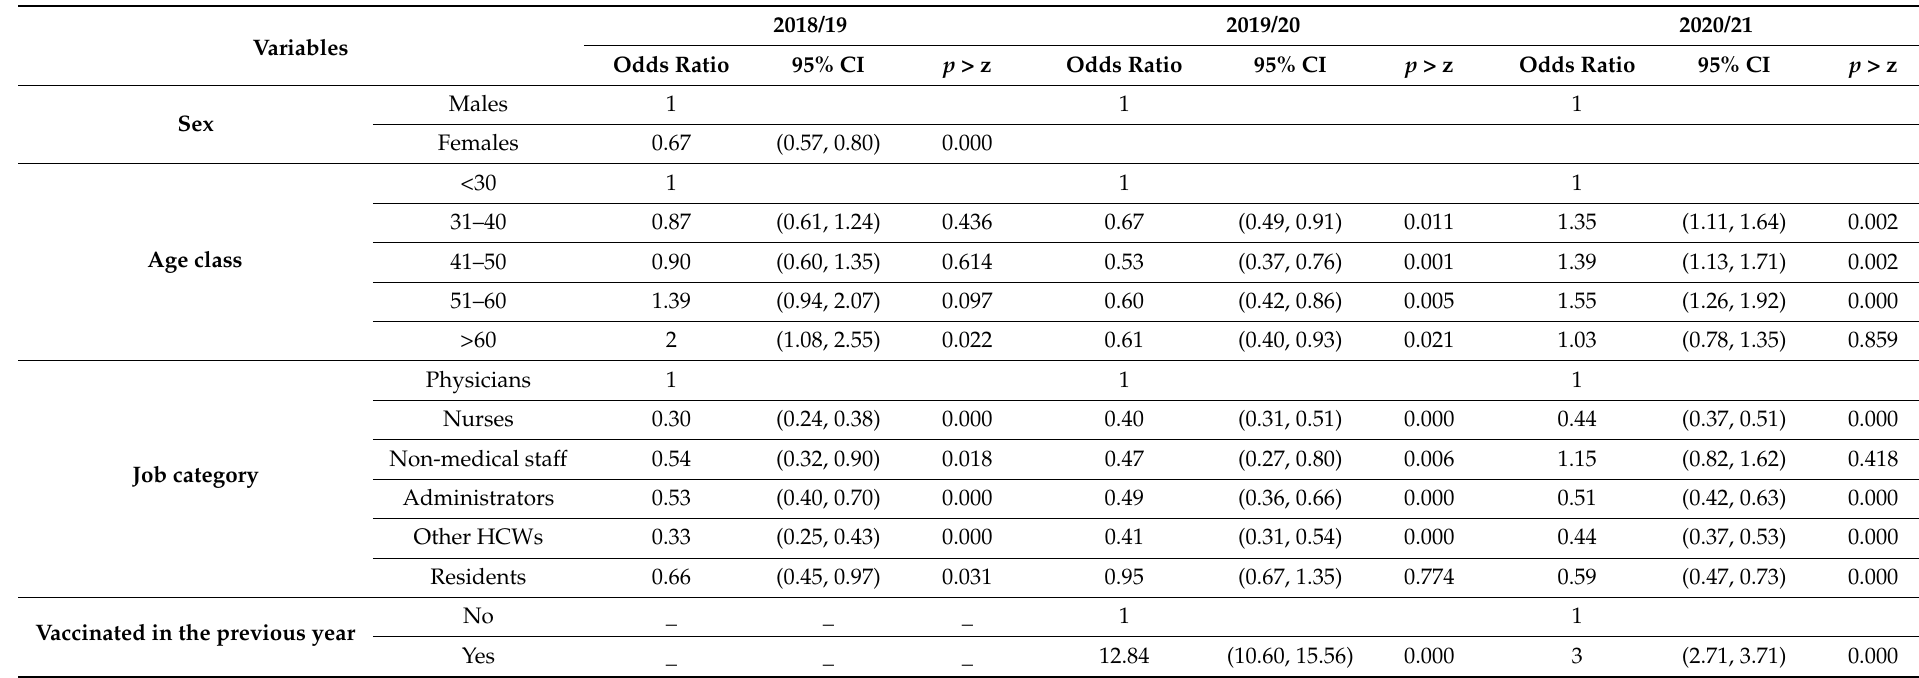
Table 3. Predictor variables of having received the flu vaccine (yes/no) during the related flu influenza season according to the multivariate logistic model analysis.